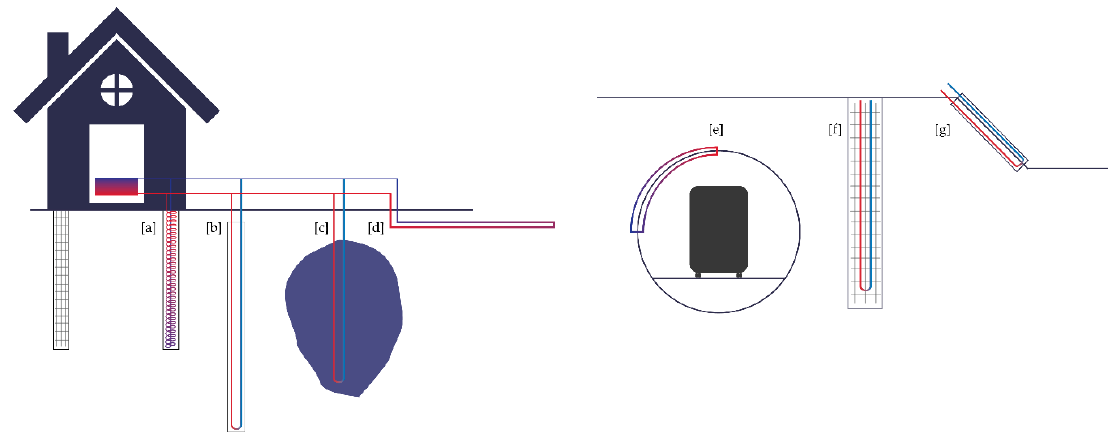
Figure 1. Examples of SGES: ( a ) Energy pile, ( b ) Vertical GHE, ( c ) Surface pond/lake, ( d ) Horizontal GHE, ( e ) Tunnel lining, ( f ) Diaphragm wall, ( g ) Embankment.